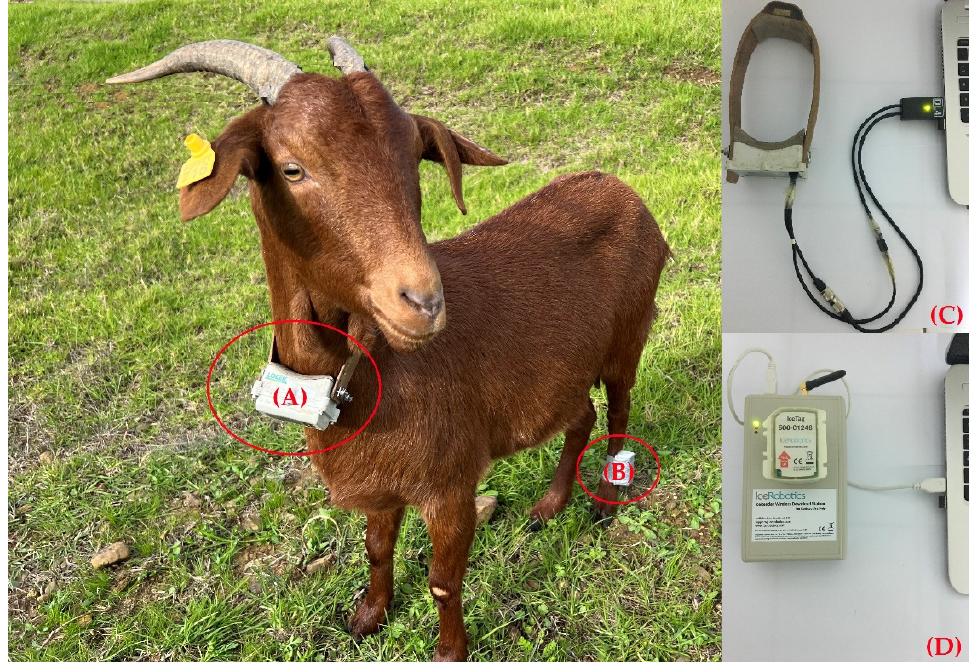
Figure 2. Indigenous goat of Beni Arouss fitted with GPS collar on the neck ( A ) and IceTag sensor on the rear left leg ( B ). Downloading GPS collar ( C ) and IceTag ( D ) data.